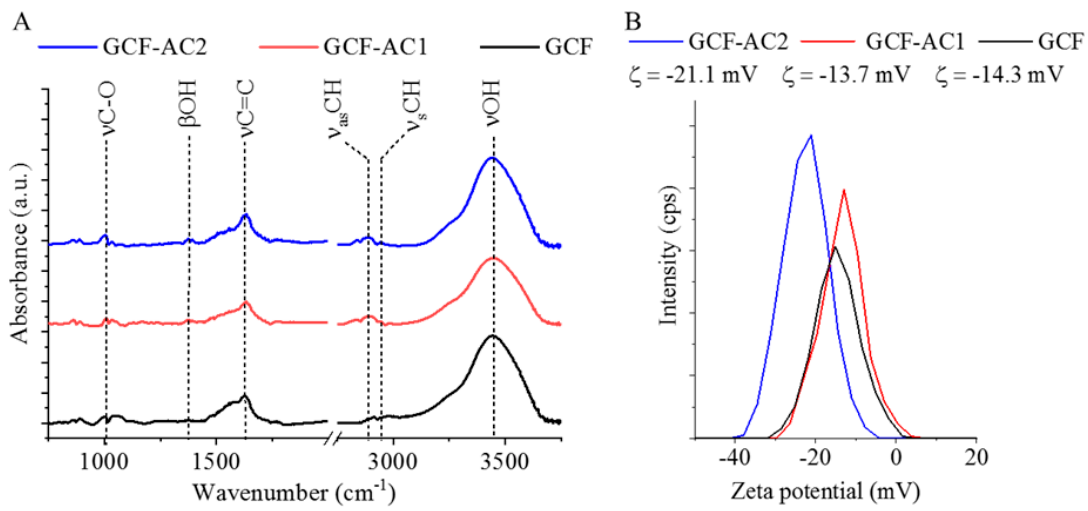
Figure 3. FTIR spectrum ( A ) and zeta potential distribution ( B ) of the Pd-decorated GCF samples. Table 2. Reaction rate constants (k) in s − 1 dependence on the reaction temperature.